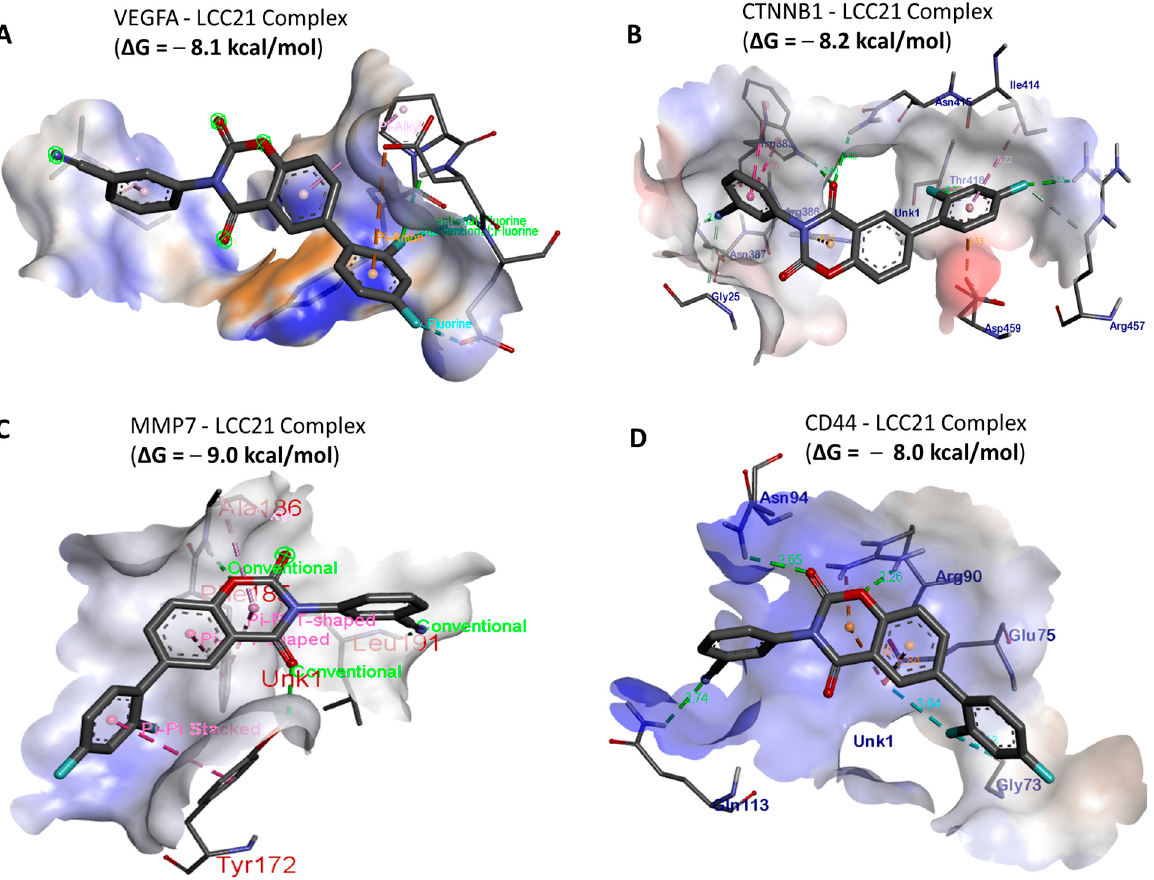
Figure 10. LCC ‐ 21 was shown to be a potential small ‐ molecule inhibitor of multi ‐ oncogenic proteins. Figure 10. LCC-21 was shown to be a potential small-molecule inhibitor of multi-oncogenic proteins. ( A – D ) 3D structures of Vascular endothelial growth factor ‐α ( VEGFA )/beta catenin ( CTNNB1 )/ma ‐ ( A – D ) 3D structures of Vascular endothelial growth factor- α ( VEGFA )/beta catenin ( CTNNB1 )/matrix trix metalloproteinase ( MMP) ‐ 7 /cluster of differentiation 44 ( CD44 ) oncogenes ‐ interactions (left) in metalloproteinase ( MMP)-7 /cluster of differentiation 44 ( CD44 ) oncogenes-interactions (left) in complex with LCC ‐ 21, with the highest respective Gibbs free binding energies of ( − ( Δ = − 8.1, − 8.2, complex with LCC-21, with the highest respective Gibbs free binding energies of ( − ( ∆ = − 8.1, − 8.2, − 9.0, and − 8.0 kcal/mol). − 9.0, and − 8.0